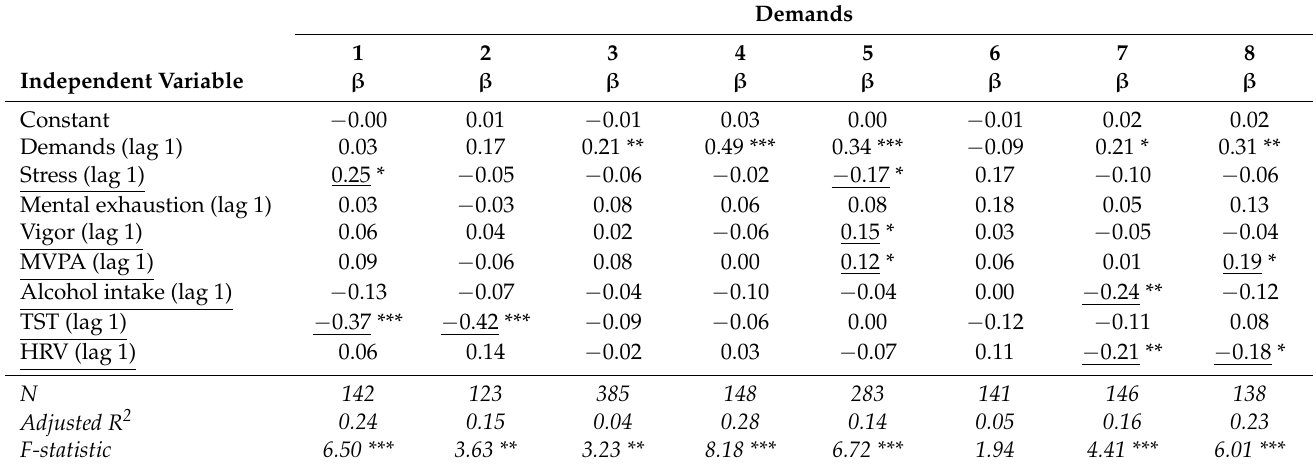
Table 4. Vector autoregression models for demands per participant